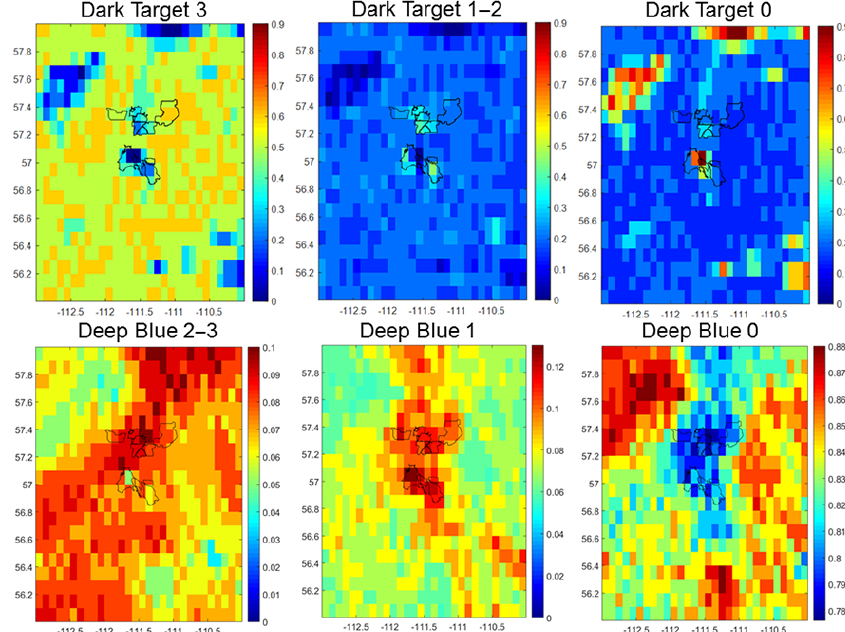
Figure 2. Maps of fraction of pixels with a specific confidence (2002–2015) for MODIS Aqua DT (top) and DB (bottom) AODs. Lower confidence is expected over Moose Lake and the Richardson sand dunes (58.0 ◦ N, 111.0 ◦ W). MODIS DB only reports a fill value when confidence is 0 in contrast to MODIS DT; thus the bottom right plot accounts for fill values, whereas the top right plot (for MODIS DT) does not.